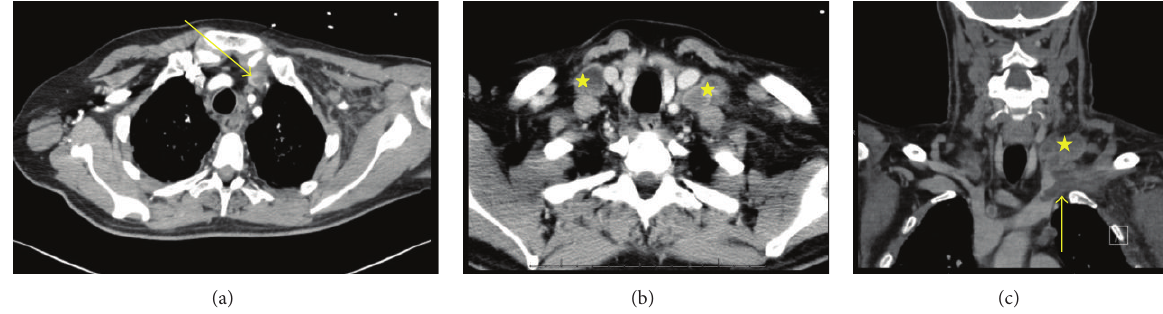
Figure 1: CT angiography showing (a) thrombus (arrow) in the left subclavian vein extending into the proximal innominate. Bilateral necrotic supraclavicular lymphadenopathy (star) does not show compression of the subclavian vein in the (b) axial and (c) coronal views.